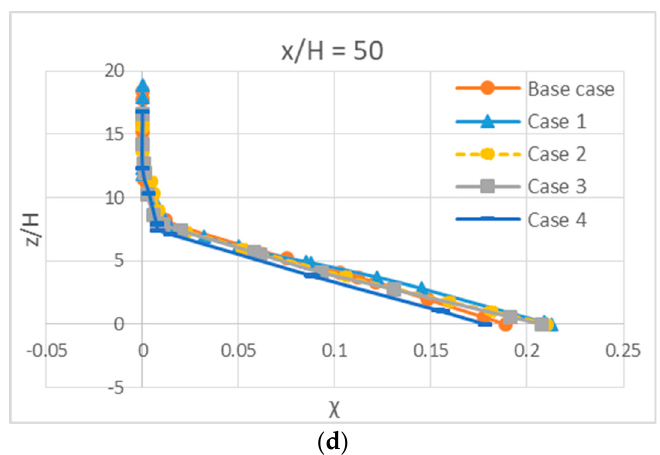
Figure 17. Vertical distribution of CO normalized concentration at different locations (H = 6 m). ( a ) x/H = 0: on the highway; ( b )( c ) x/H = 5, 10: near the highway; ( d ) x/H = 50: far downstream.